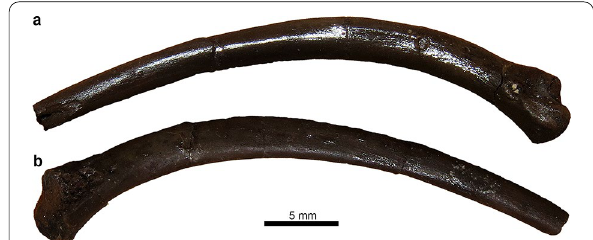
Fig. 110 Constrictores indet. from quarry XLI, Geiseltal: isolated rib (GMH XLI-314a-1968) in posterior ( a ) and anterior ( b )